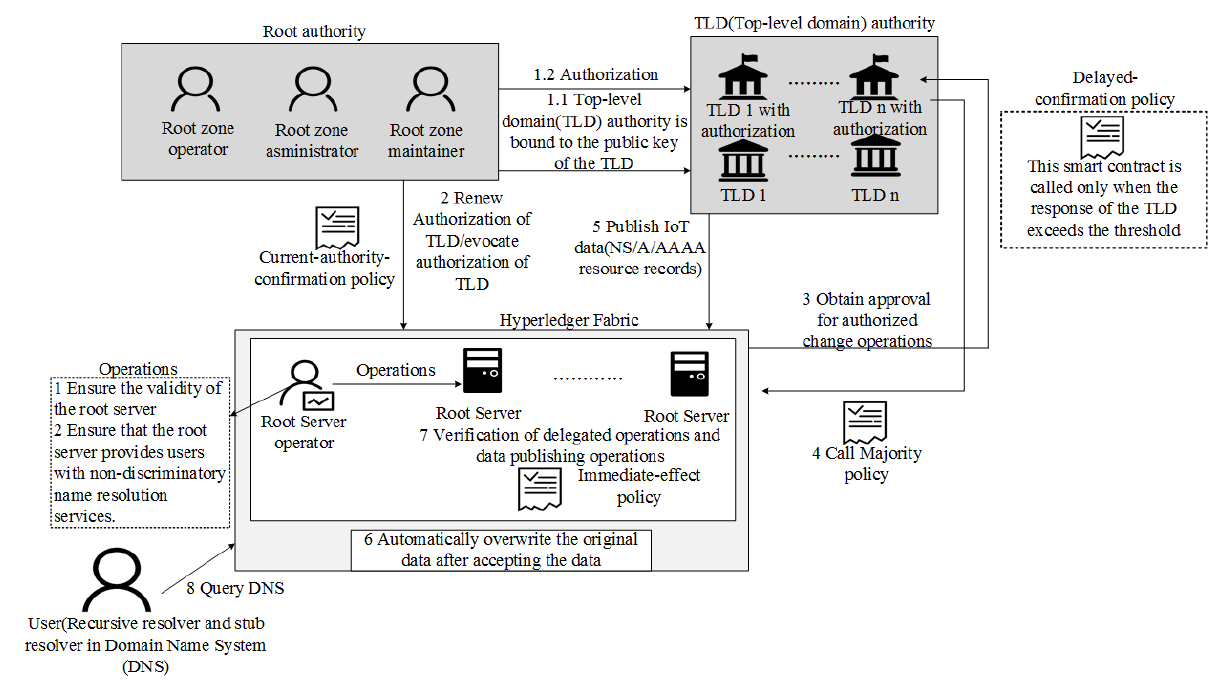
Figure 12. Reconstruction diagram of reference [33].